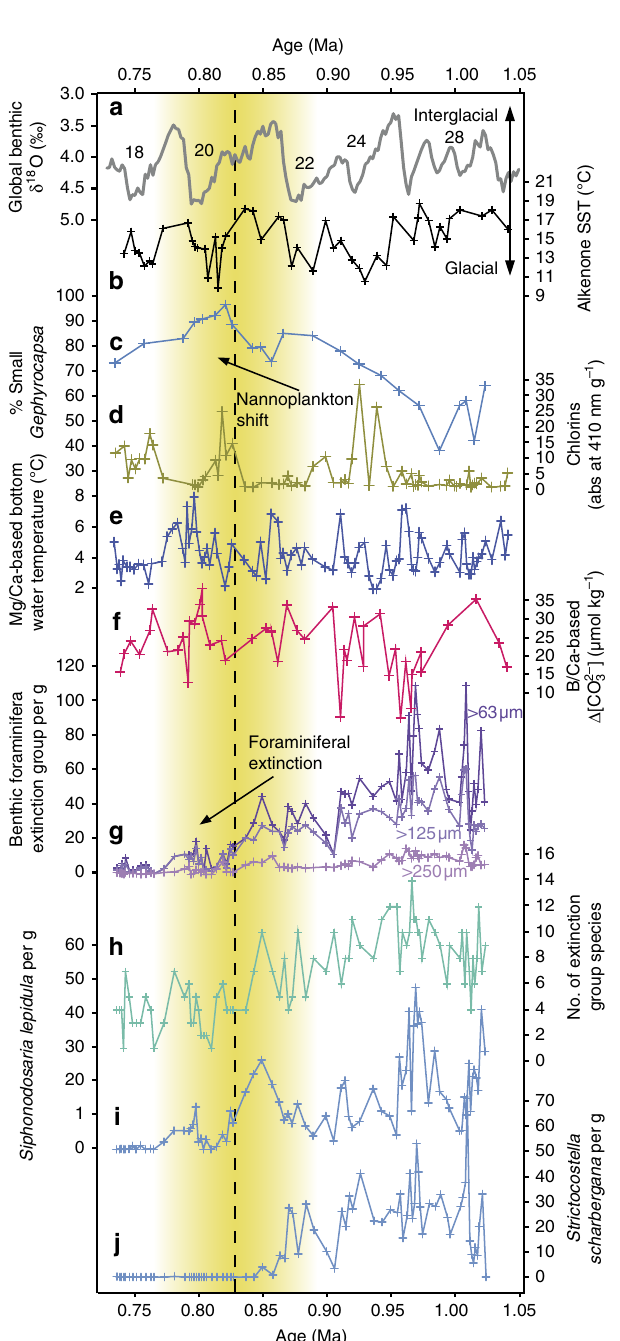
Figure 1 | Reconstructed environmental proxies for Tasman Sea DSDP Site 593. ( a ) Global benthic foraminifera d 18 O composite 52 showing colder glacial (positive) and interglacial cycles. ( b ) Sea-surface temperature reconstructed from alkenones. ( c ) Small Gephyrocapsa as a % of total nannofossil assemblage. ( d ) Concentration of chlorin pigments used here as a proxy for photosynthetic material related to primary productivity 24 . ( e ) Bottom-water temperature reconstructed from benthic foraminiferal U. peregrina Mg/Ca ratios. ( f ) Bottom-water D [CO 3 2 (cid:2) ] reconstructed from benthic foraminiferal C. wuellerstorfi B/Ca ratios. ( g – j ) Abundance per g and number of species of benthic foraminifera from the extinction group. Note that none of the environmental proxies ( d – f ) follows abundance of the foraminiferal extinction group ( g – j ). The vertical yellow bar indicates the interval over which the foraminiferal extinction occurs, and the vertical dashed line indicates where small Gephyrocapsa dominates the assemblage.